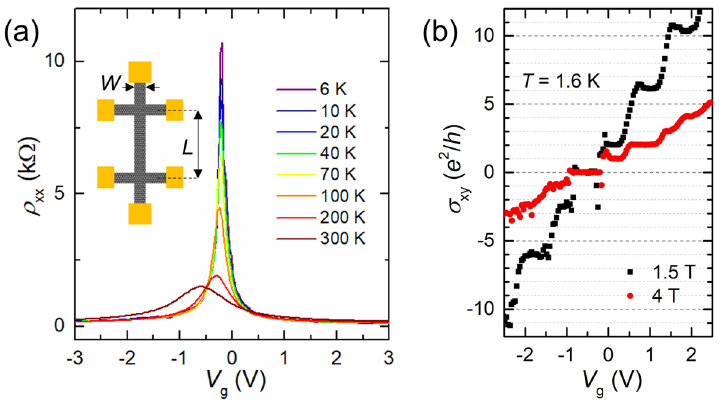
Figure 1. ( a ) Longitudinal resistivity of the device as a function of back-gate voltage for various temperatures. Inset: a schematic illustration of the Hall-bar channel geometry. The symbols L and W indicate the channel length and width, respectively. ( b ) Hall conductivity of the device as a function of back-gate voltage at T = 1.6 K. The black square corresponds to the data at B = 1.5 T, and the red circle at B = 4